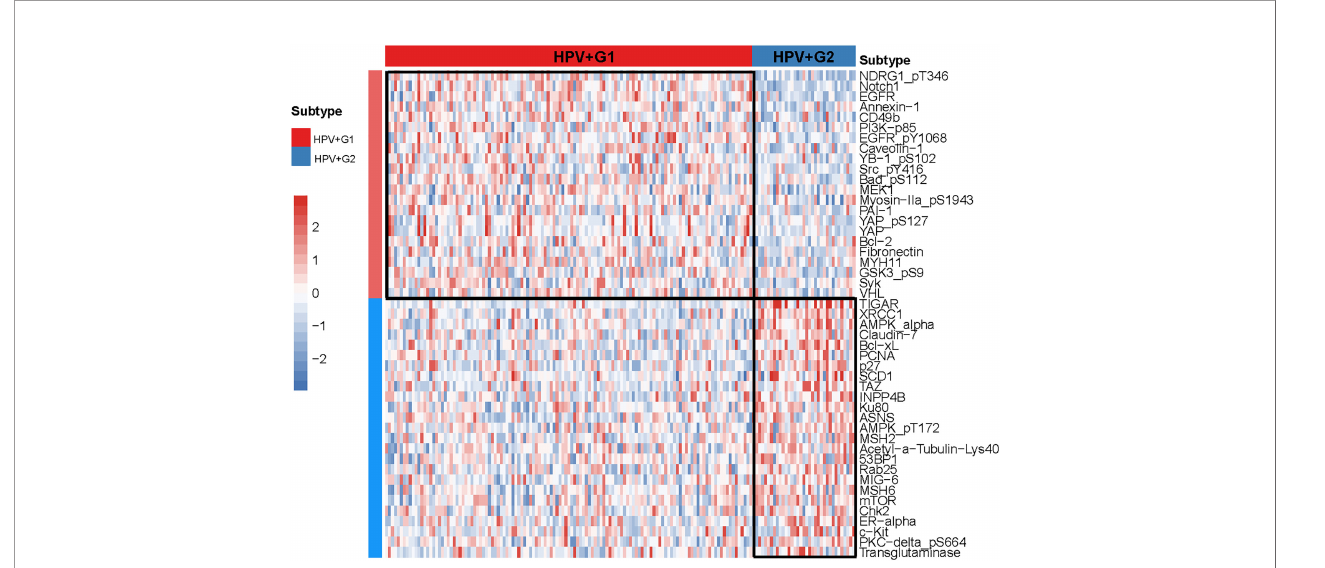
FIGURE 4 | Heatmap showing 22 and 25 proteins upregulated in HPV+G1 and HPV+G2,